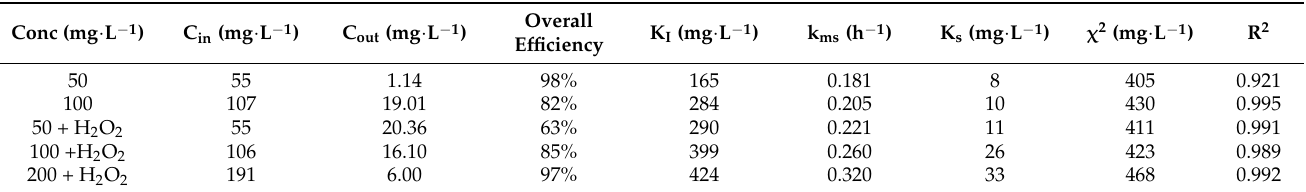
Table 4. Kinetic parameter estimation for the biological reactor at different initial concentrations using AQUASIM (Haldane model).